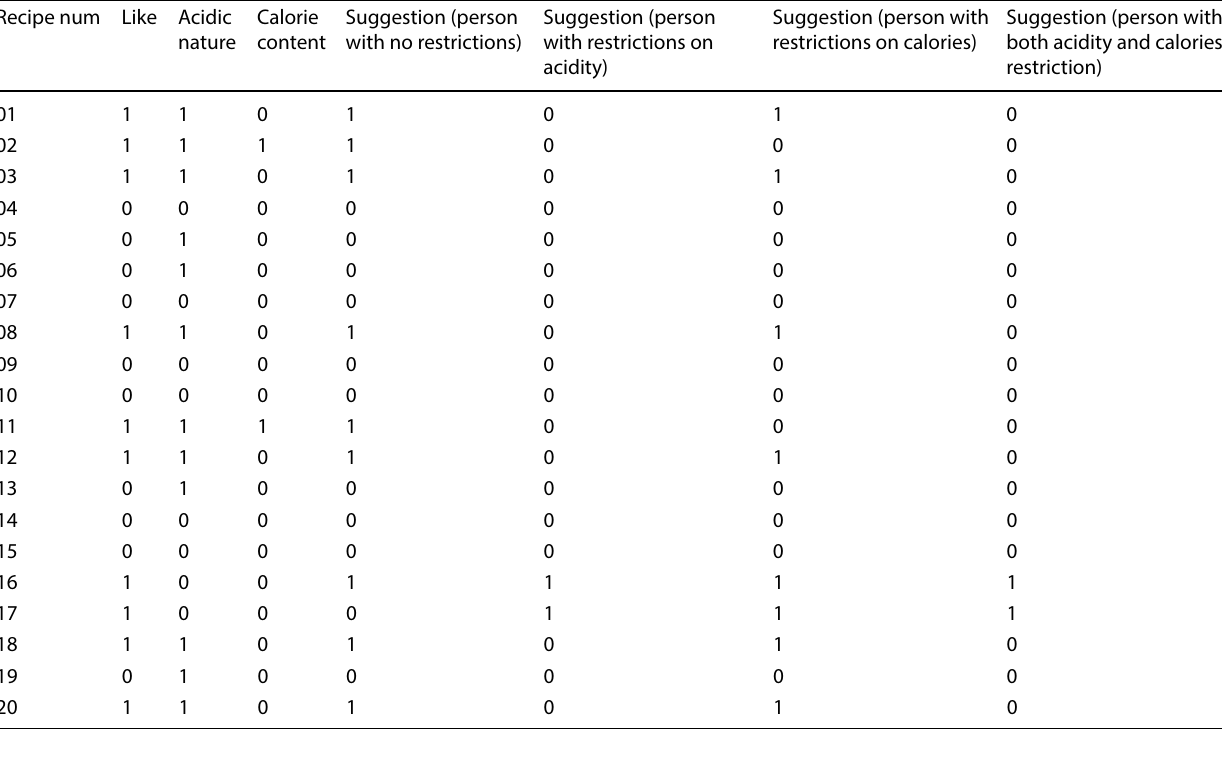
Table 11 The suggestions after binary conversion and passing through the logic circuit Recipe num Like Acidic Calorie Suggestion (person Suggestion (person nature content with no restrictions) with restrictions on